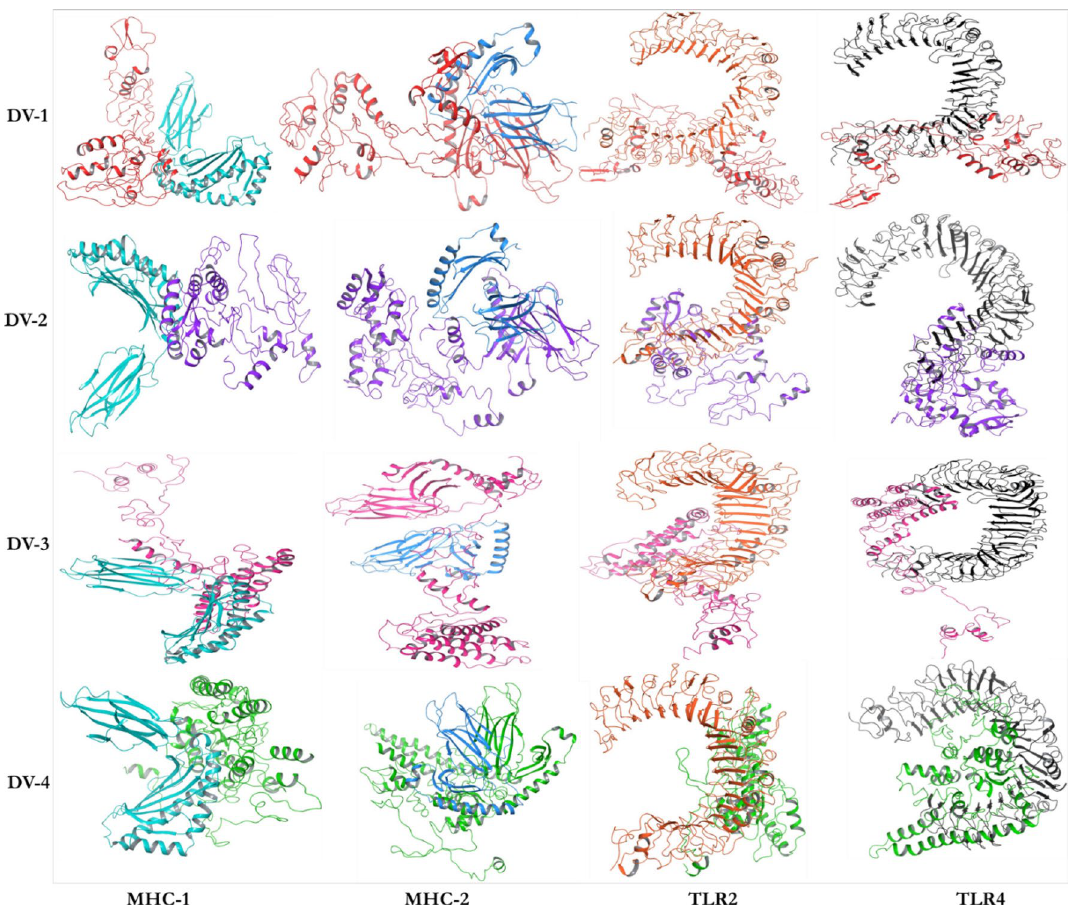
Figure 5. Docking poses of the predicted DENV vaccines against selected immunological receptors (Schrodinger suite v2020-3).